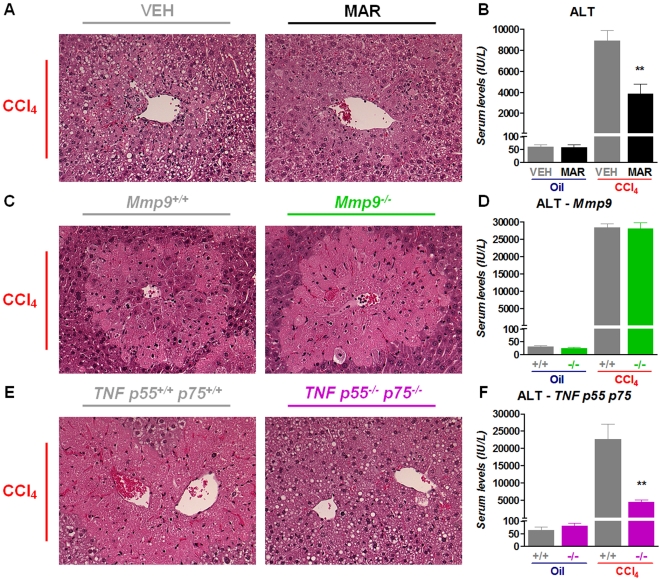
Marimastat reduces necroinflammatory injury following a single dose of carbon tetrachloride (CCl4) via a TNF-dependent pathway.Liver sections from Marimastat-treated animals that had been administered a single dose of CCl4 revealed decreased necroinflammatory injury after 24 h (A). Marimastat treatment resulted in a 57% decrease of serum ALT levels (B). Liver sections from Mmp9−/− and wild type (Mmp9+/+) animals that were challenged with a single dose of CCl4 showed comparable, extensive necroinflammatory changes around the central veins after 24 h (C). Serum ALT levels of Mmp9−/− animals were similar to those of wild type controls (D). 24 h after a single dose of CCl4, liver sections from wild type (TNF p55+/+ p75+/+) animals revealed extensive necrosis and inflammation around the central veins, whereas TNF p55−/− p75−/− animals showed markedly reduced hepatic injury (E). Serum ALT levels in TNF p55−/− p75−/− animals were 5-fold lower compared to wild type controls, corroborating the findings on histology and indicating decreased hepatic injury in animals lacking both TNF-receptors (F). Oil, non-fibrotic control group; CCl4, fibrotic mice; VEH, vehicle treated control group; MAR, Marimastat treated experimental group; +/+, wild type controls; −/−, knock out animals; ALT, alanine aminotransferase; TNF, tumor necrosis factor; **, P<0.01 vs. vehicle alone. Data are expressed as means ± standard error. Original magnification: 300×.